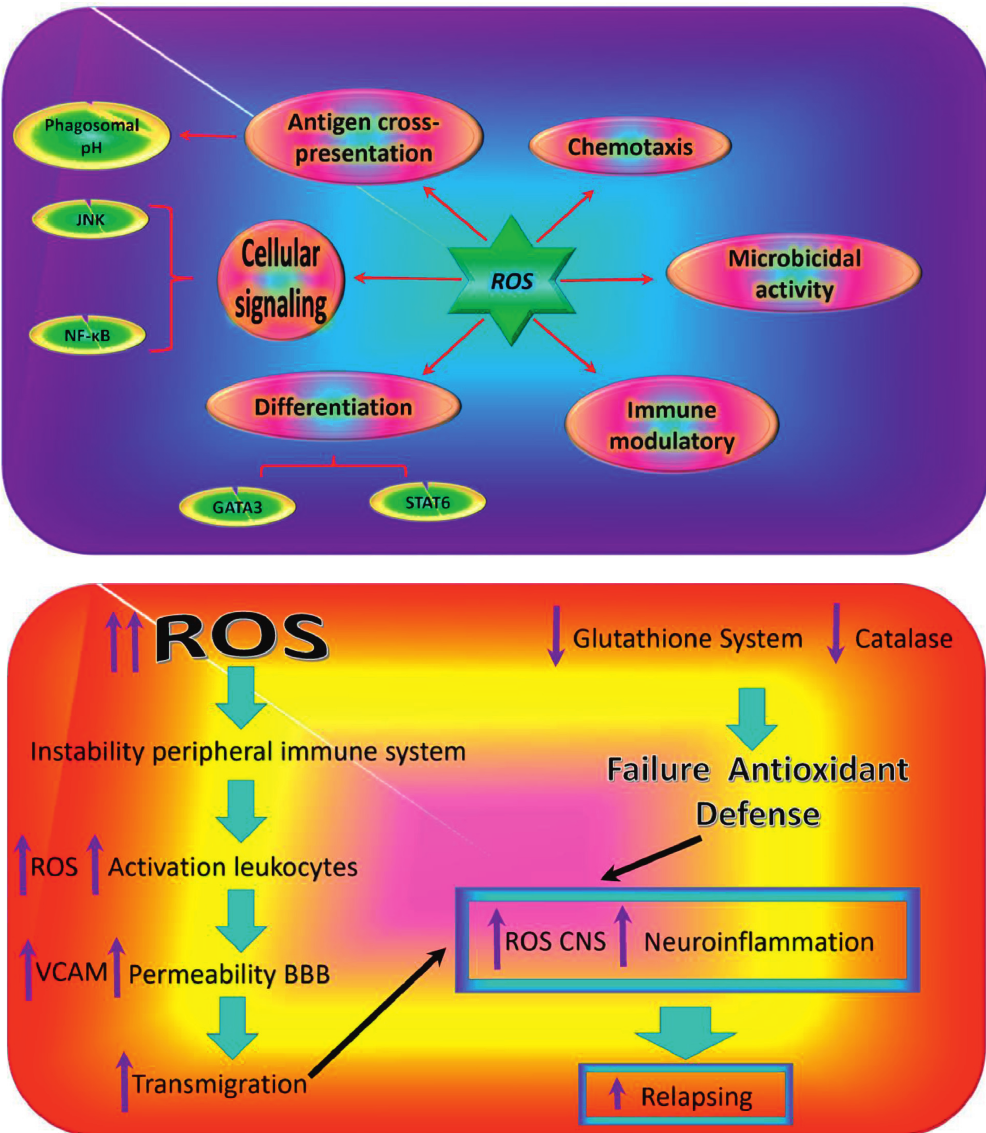
Figure 3: Summary of ROS function in the pathogenesis MS. CNS, central nervous system; VCAM, vascular cell adhesion